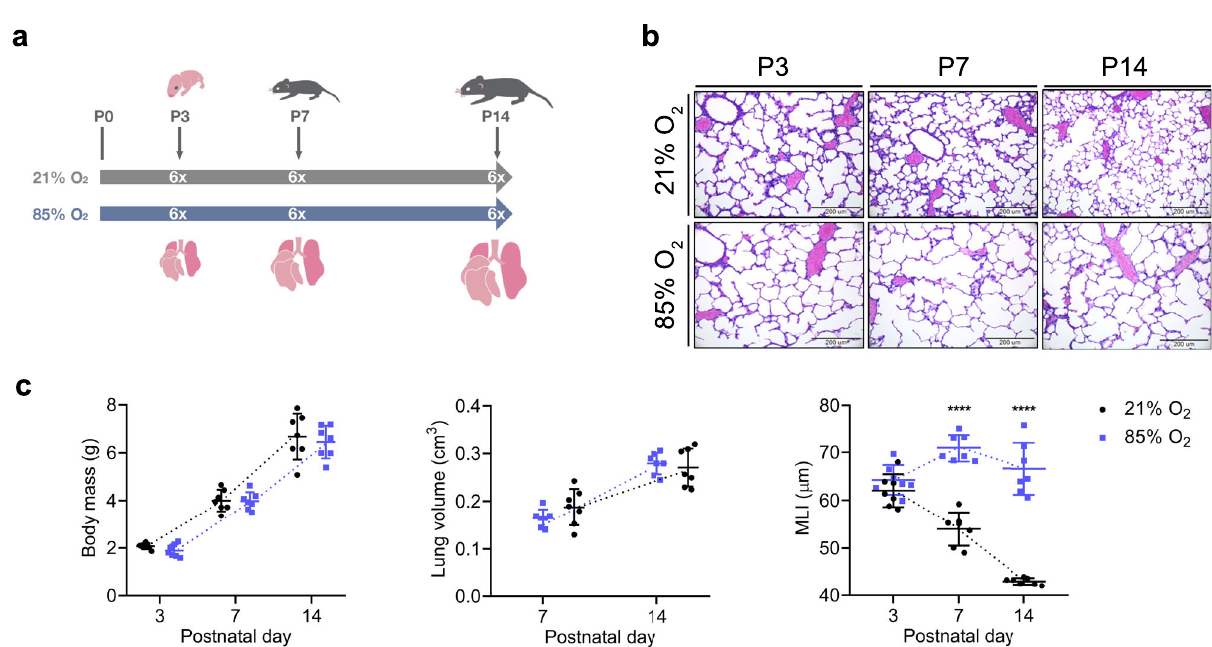
Fig. 1 Exposure to hyperoxia induced an arrest in alveolarization in the developing mouse lung. a Mouse pups were exposed from day of birth to room air (21% O 2 , gray) or hyperoxia (85%O 2 , blue). A total of 36 lungs were harvested on postnatal days (P)3, 7, and 14. n = 6/group. b Representative histological sections from lungs developing in 21% O 2 (black circles) or 85% O 2 (purple squares) at P3, P7, and P14. Seven animals/group were evaluated. Scale bar = 200 µ m. c Body weight was assessed at P3, P7, and P14. Lung volume was assessed by Archimedes principle at P7 and P14. Precise measurements at P3 were not possible due to the small size of the organ. Lung morphometry was quanti fi ed by the mean linear intercept (MLI) measurement. Data are presented as means ± SD. Statistical analyses were performed with GraphPad Prism 8.0. The presence of potential statistical outliers was determined by Grubbs ’ test. Signi fi cance was evaluated by multiple unpaired Student ’ s t- test with Holm – Sidak correction. P values **** = <0.0001. n = 7